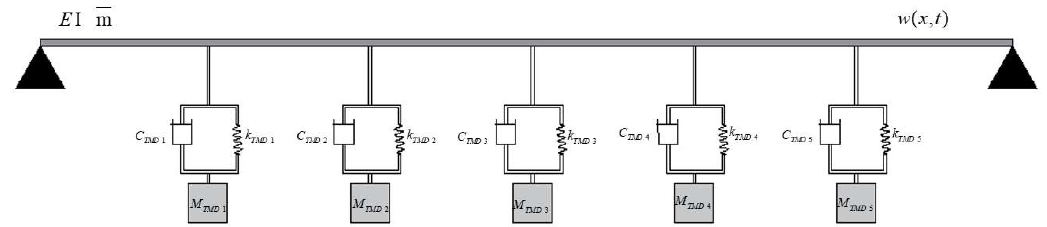
Figure 1. Euler–Bernoulli beam fitted with 5 tuned mass dampers (TMDs).